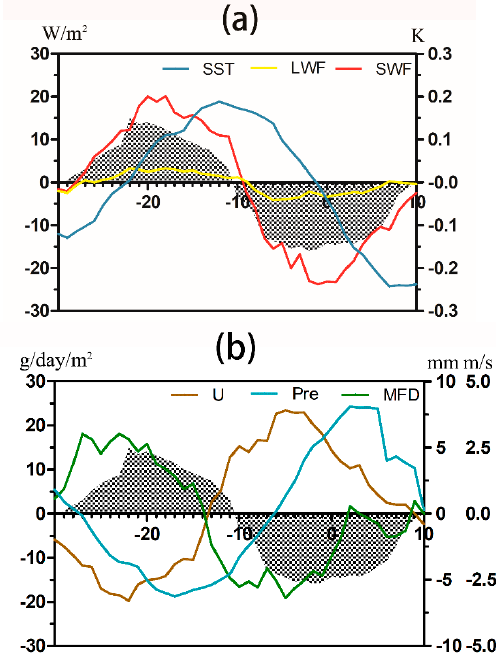
Figure 9. Temporal evolution of the composite original anomalies (based on the PC1 coefficient of EOF models) in the SCS region, for ( a ) downward short-wave radiation flux (SWF, red line), upward long-wave radiation flux (LWF, yellow line) and SST (blue line); ( b ) precipitation (Pre, cyan line), horizontal wind speed (U, brown line), and moisture flux divergence (MFD, green line). Gray shaded areas indicate the corresponding composite OLR anomalies, and the x-coordinate indicated the number of lead/lag days. Atmosphere 2020 , 11 , x FOR PEER REVIEW Figure 9b shows BSISO-related anomalies of precipitation (Pre), horizontal wind speed (U), and moisture flux divergence (MFD). As seen in Figure 9a, these three variables are also closely related to OLR anomalies. Active convection is always accompanied by low-level cyclonic circulation anomalies, and water vapor brought by enhanced southwest air currents leads to increases in air humidity. Meanwhile, increased atmospheric instability and convective precipitation also causes water vapor to mix evenly in the vertical direction, thus reducing the difference in air–sea humidity. By this physical mechanism, the BSISO affects the evaporation duct over the SCS (Figure 10).